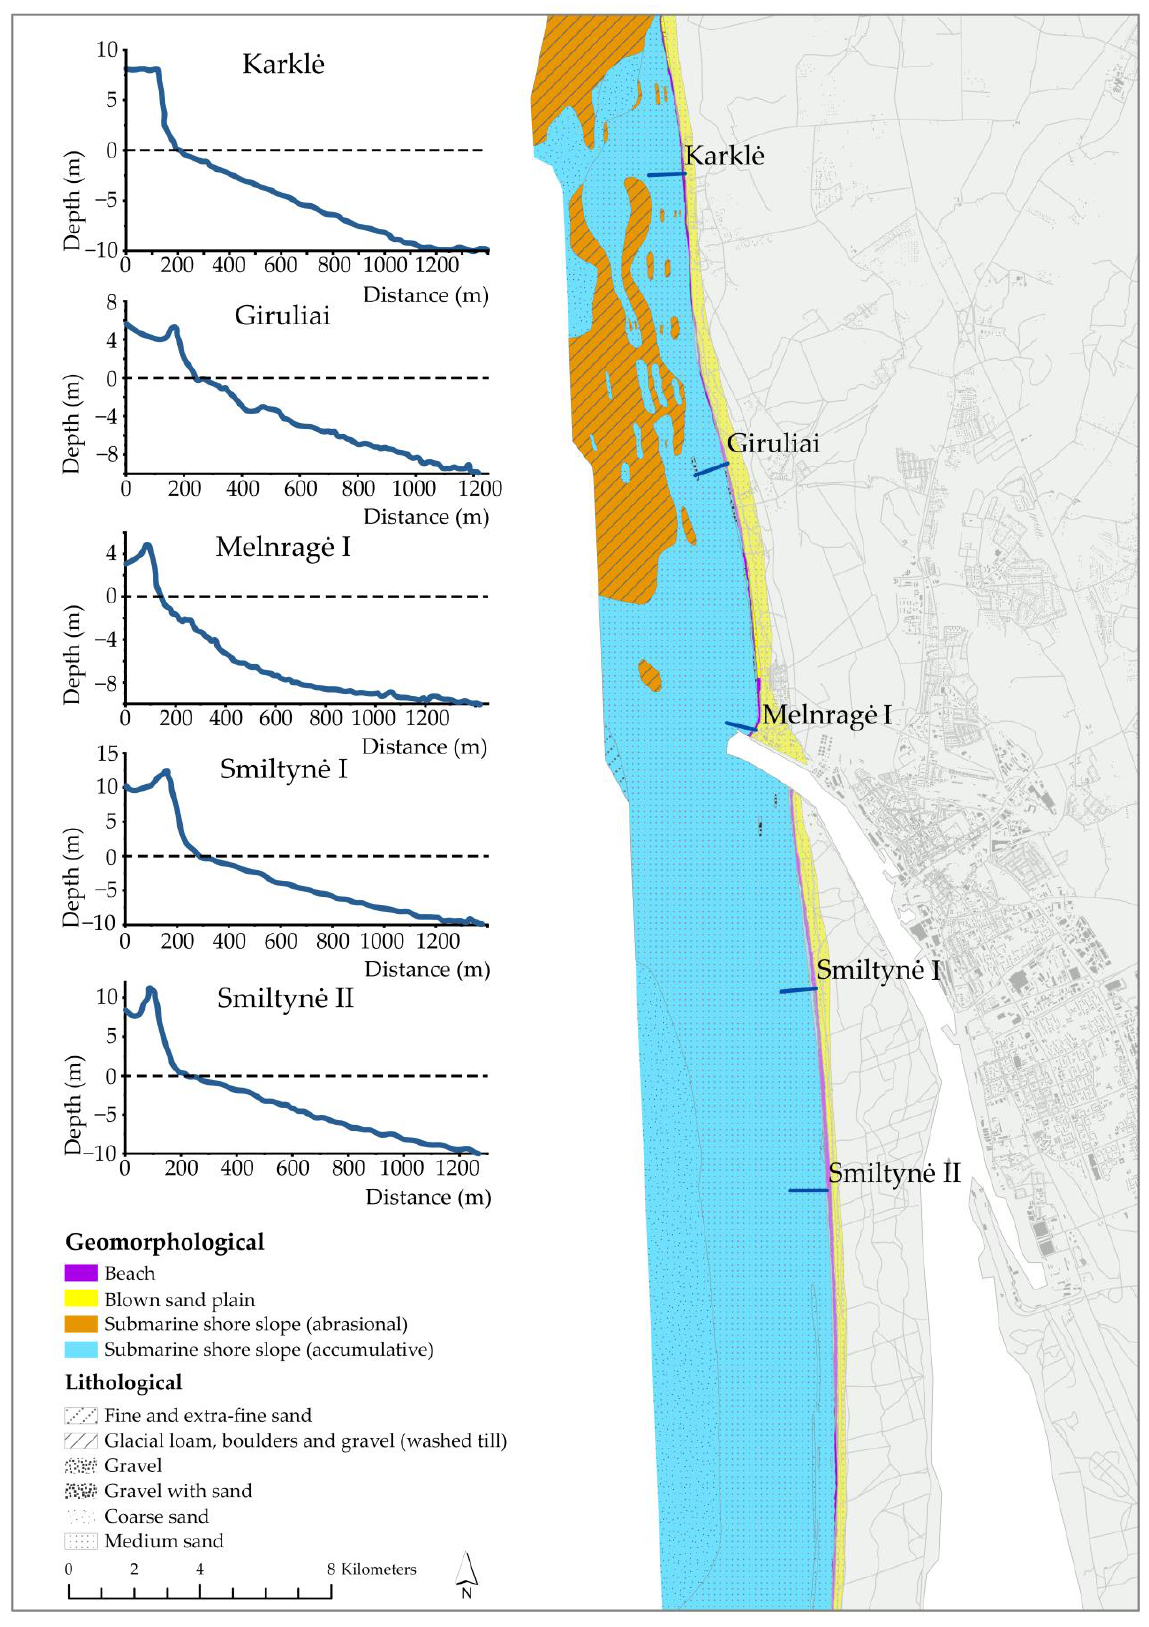
Figure 2. Geomorphological map of the study area.